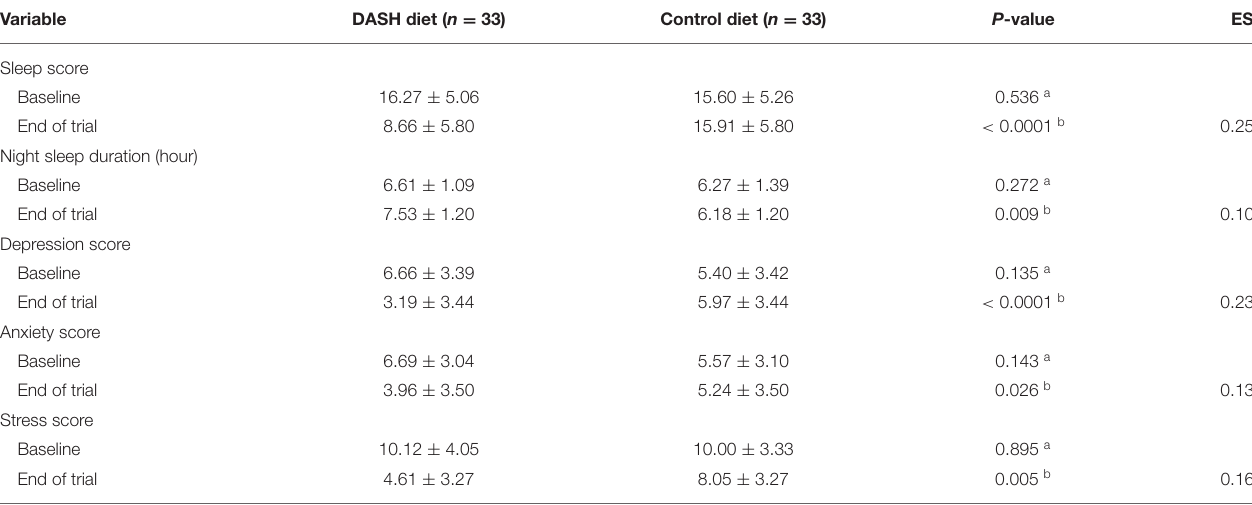
TABLE 5 | Sleep, stress, anxiety, and depression scores at baseline and after 12 weeks of intervention in postmenopausal diabetic patients. Variable DASH diet ( n = 33) Control diet ( n = 33) P -value